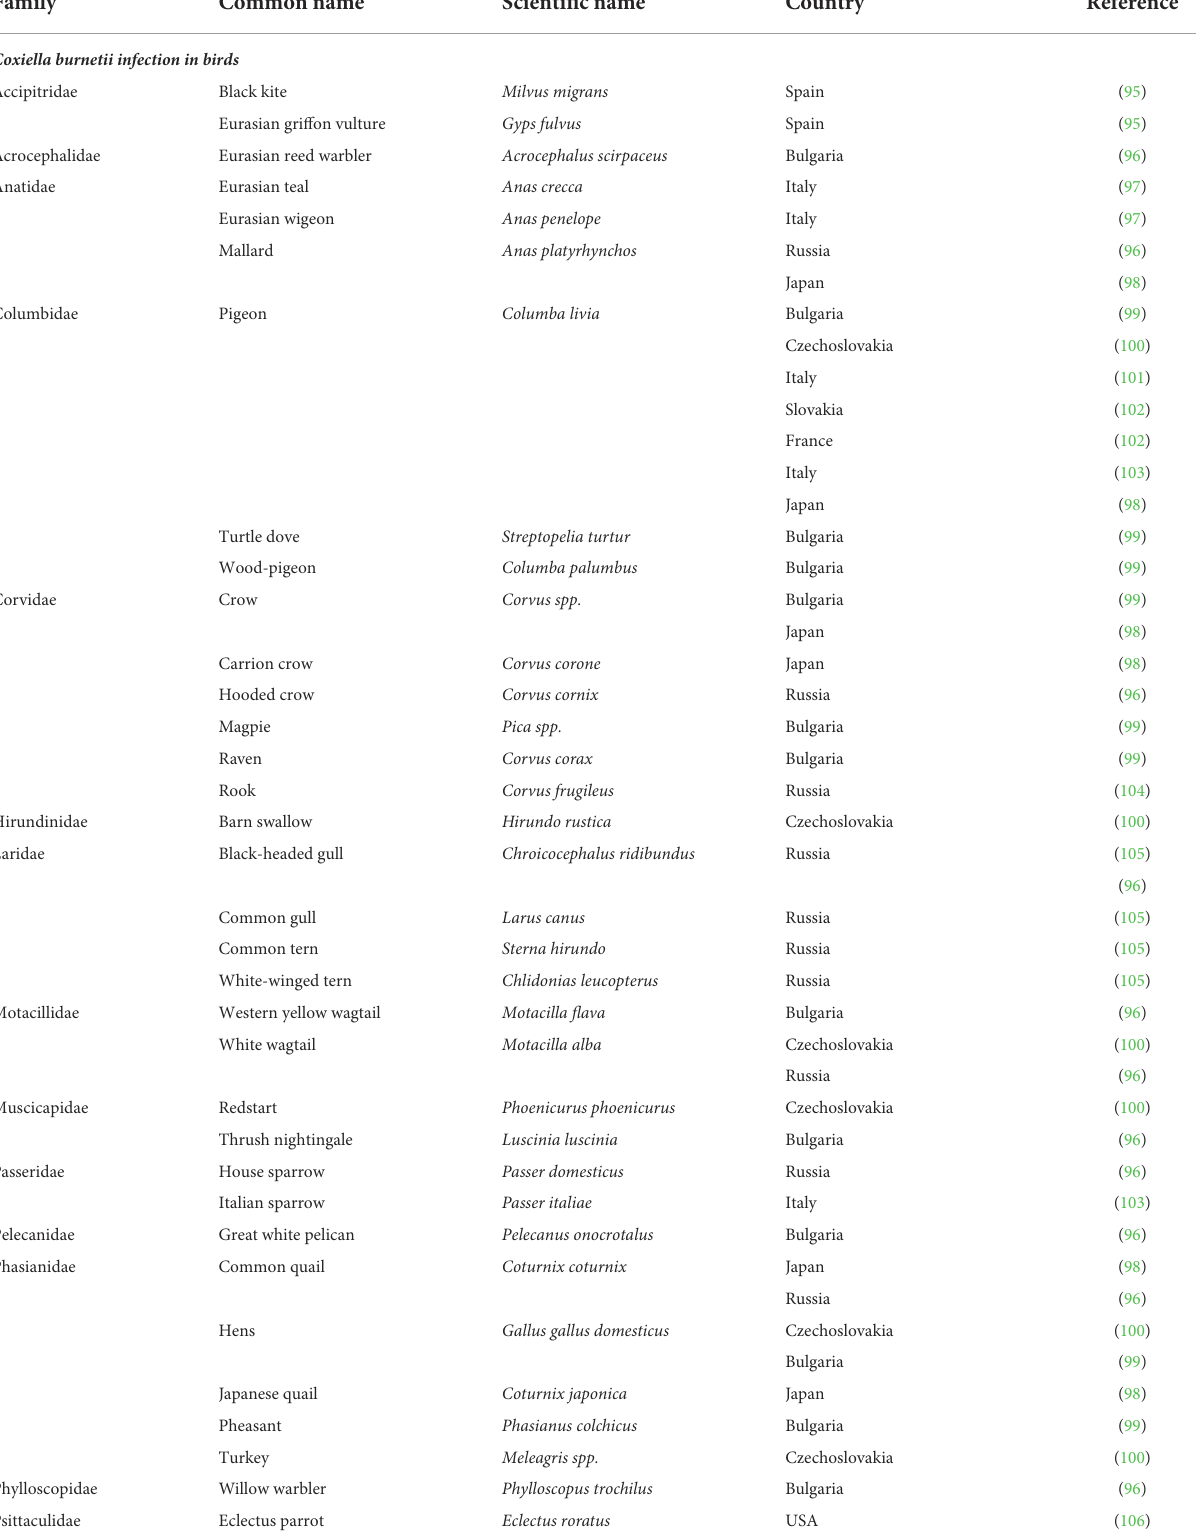
TABLE 1 List of animal species infected by Coxiella burnetii